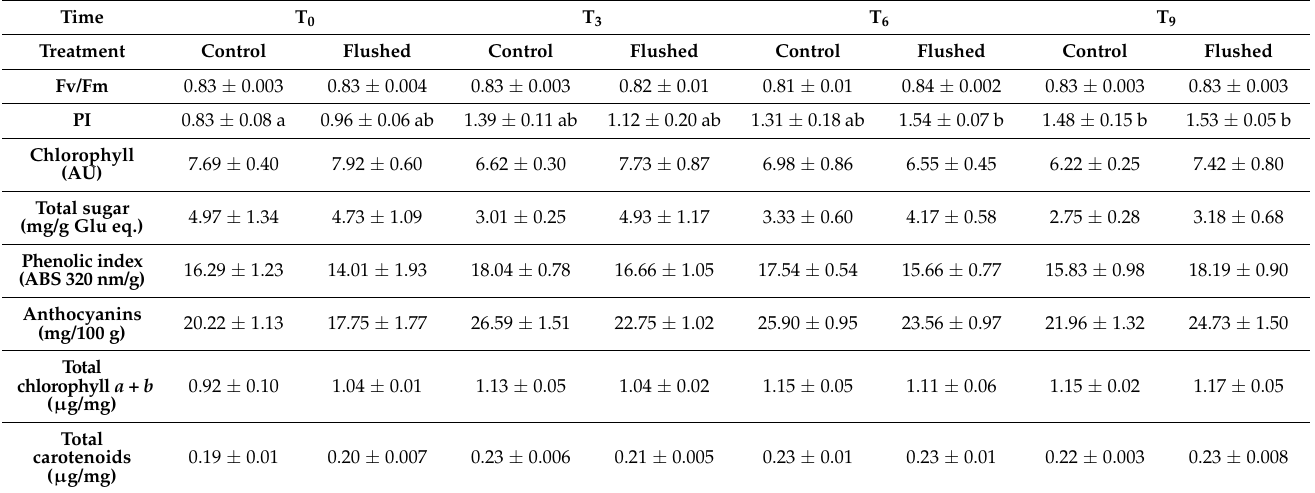
Table 2. Quantitative and qualitative parameters measured at harvest and during storage at three, six and nine days after the harvest of treated (flushing 48 h) and untreated Lactuca sativa